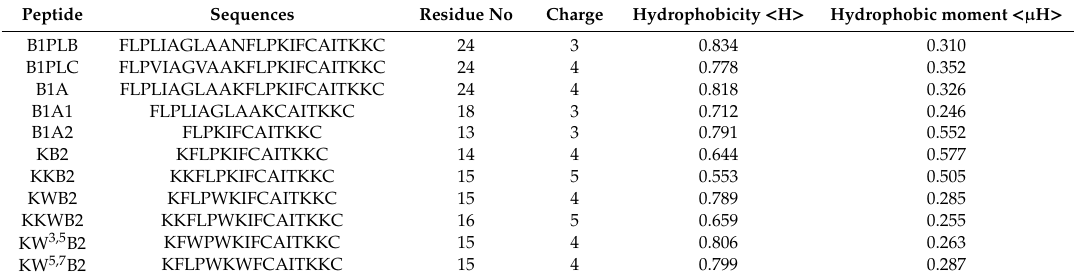
Table 1. The physicochemical properties of Brevinin-1 peptides and B1A’s analogues.